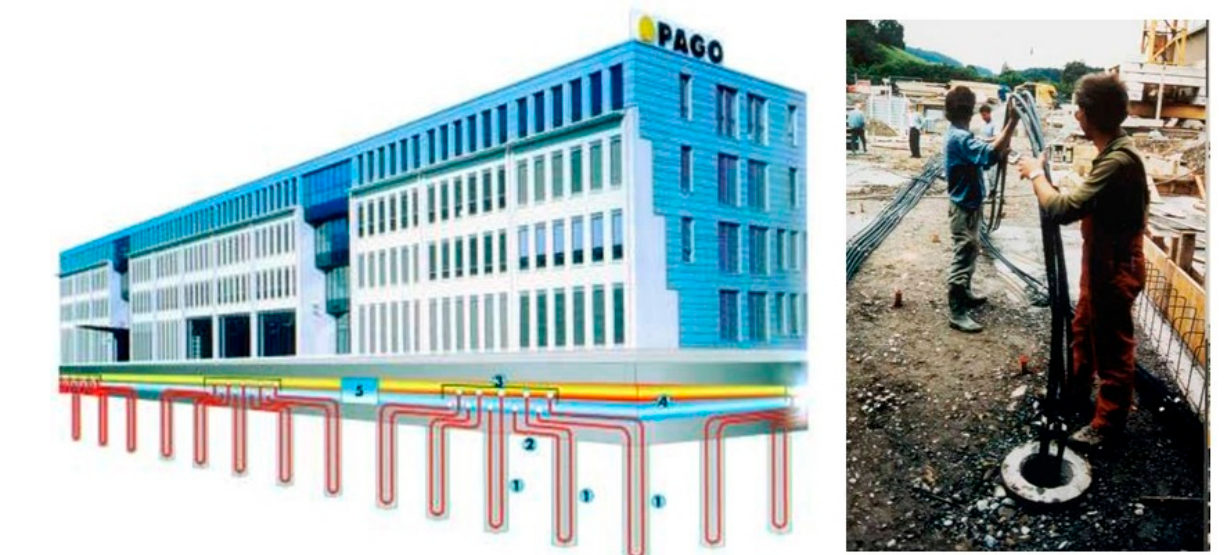
20 of 29 Figure 18. Stability of fluid temperatures from BFE during the time period from 1987 to 2009, for a single-family house, from data in [27]. T s : temperature of return fluid from BHE. For details, see text. 4.4. BHEs below Buildings Historically, GHPs were mainly installed for already existing singe houses, usually just next to the buildings. Nowadays, BHEs are placed below the buildings to be erected (in the construction pit, below the base plate). Another, useful solution are the “Energy Piles”. Ref. [2] describes them as follows: “Energy piles are foundation piles equipped with heat exchanger piping. The piles are installed in grounds with poor load-bearing properties. The energy piles use the ground beneath buildings as heat source or sink, ac- cording to the season. The systems need careful design, taking into account especially the